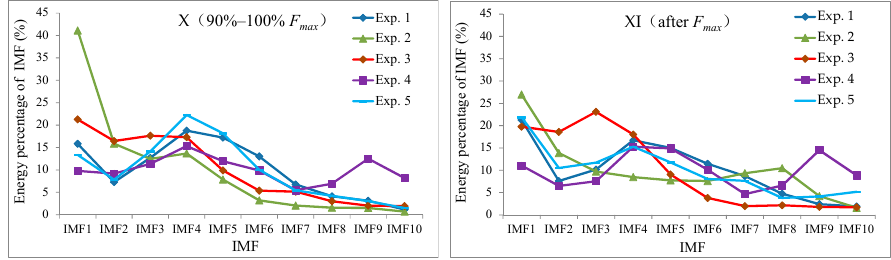
Figure 9. IMF energy percentage graph in the fracture process ( X ) and after a fracture ( XI ).